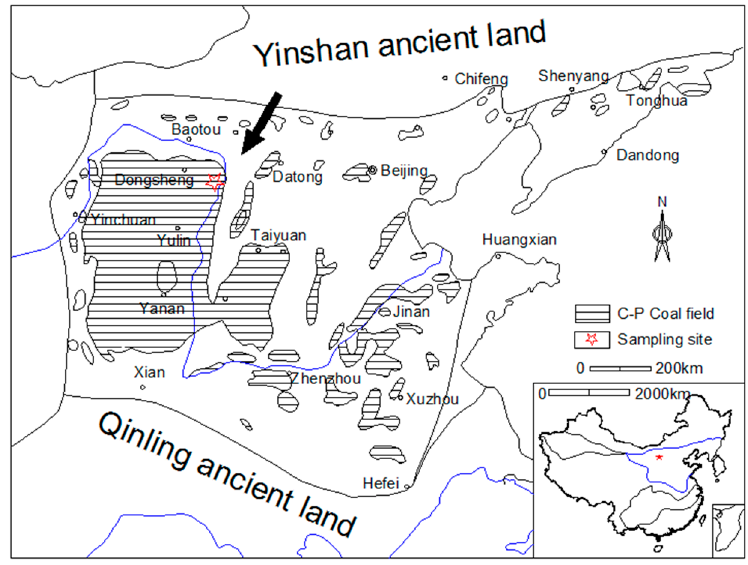
Figure 13. The Permo-Carboniferous coalfield map in northern China. Reproduced with permission from Yang et al. [55], published by Coal Industry Press, 2000.